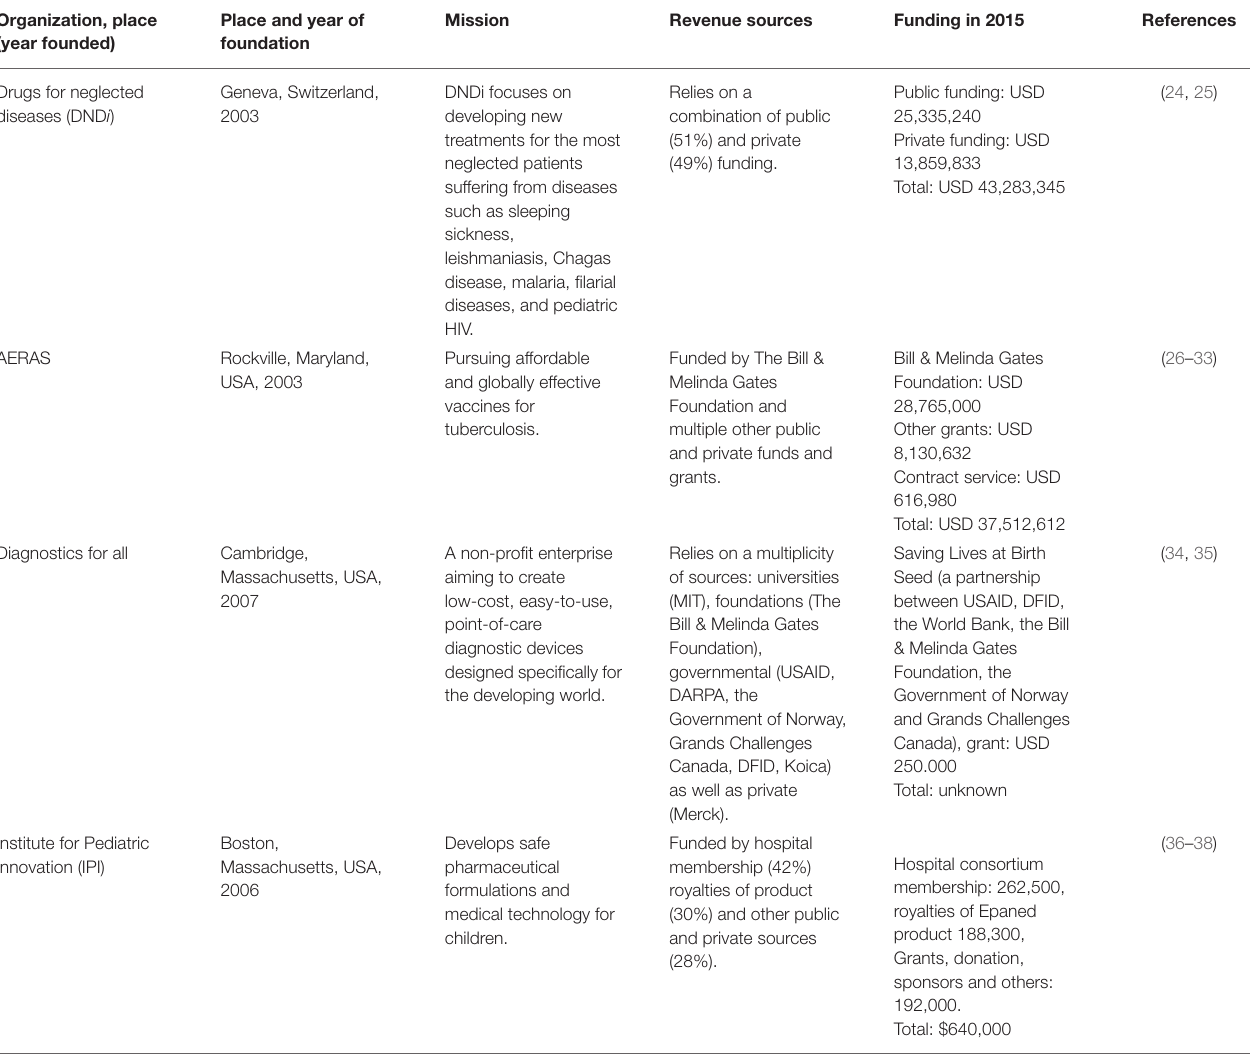
TABLE 2 | Funding sources of several social bioentrepreneurship